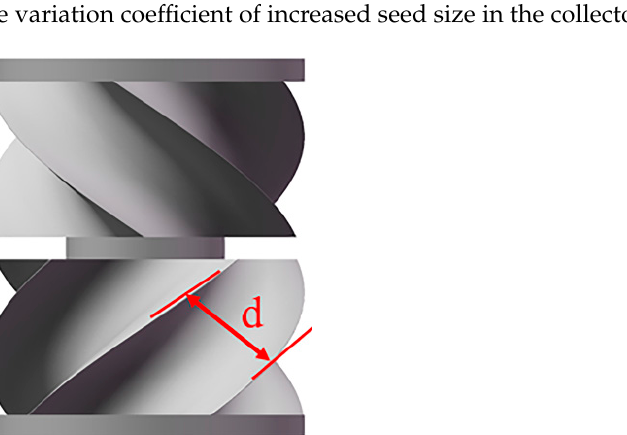
Figure 11. Effect of spiral groove inclination change on seed increment.